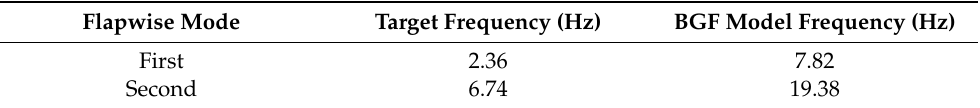
Figure 18. Experimental and target (DTU 10 MW) first and second flapwise modes. Table 9. Comparison between the frequency of the first flapwise modes for the DTU 10 MW (target) and the experimental frequencies of the outdoor prototype (BGF) (frequencies are reported at the model scale).